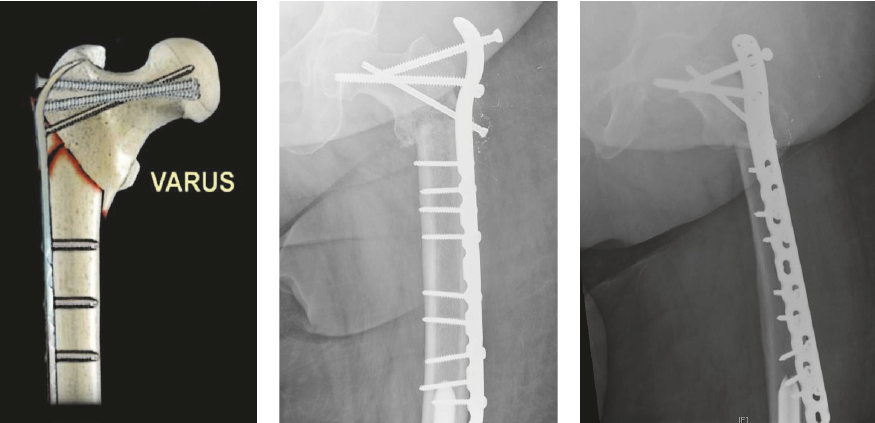
Figure7:Varuscollapseofsubtrochantericfemurfractures:Thisdiagramillustratesandprovidesaradiographicexampleofasubtrochanteric fracture varus